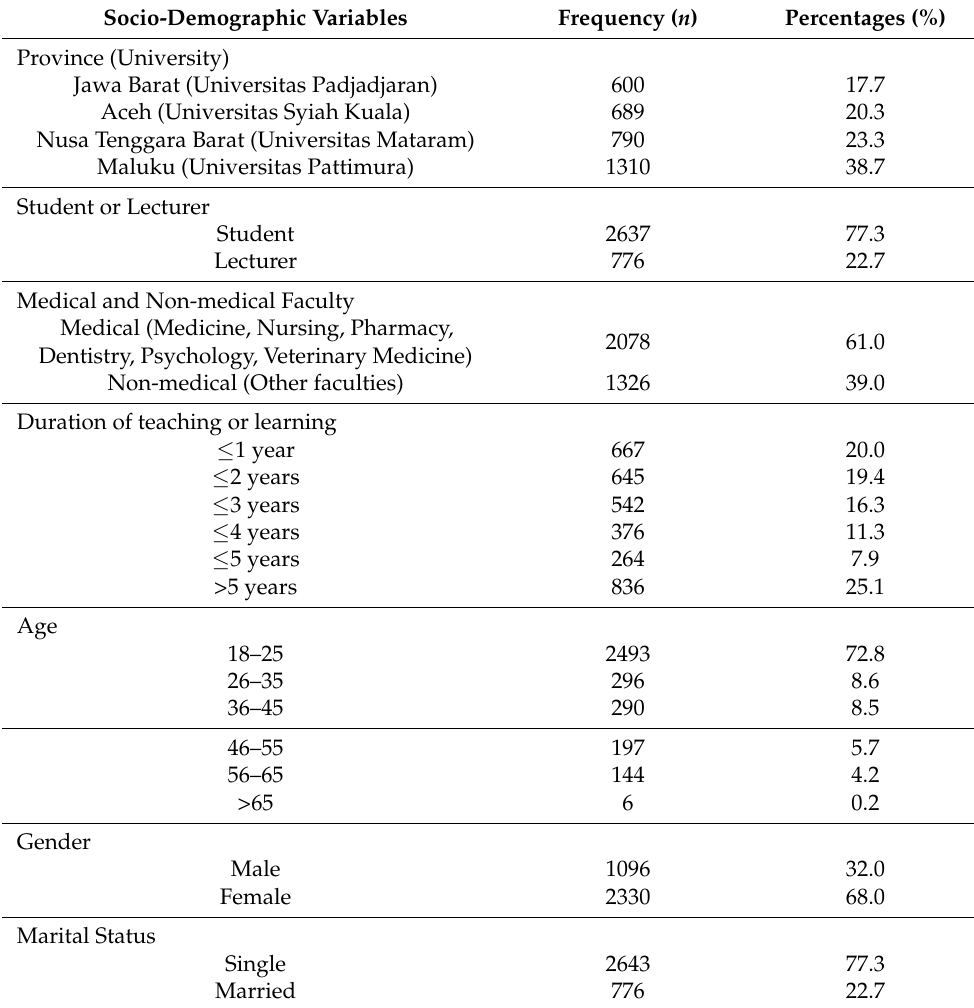
Table 1. Socio-demographic characteristics with frequency ( n ) and percentages